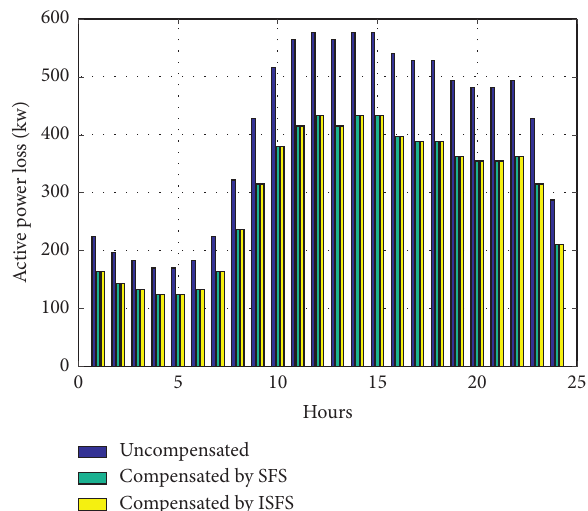
Figure 29: Power losses of 152-bus network within 24-hour interval before and after compensation in scenario